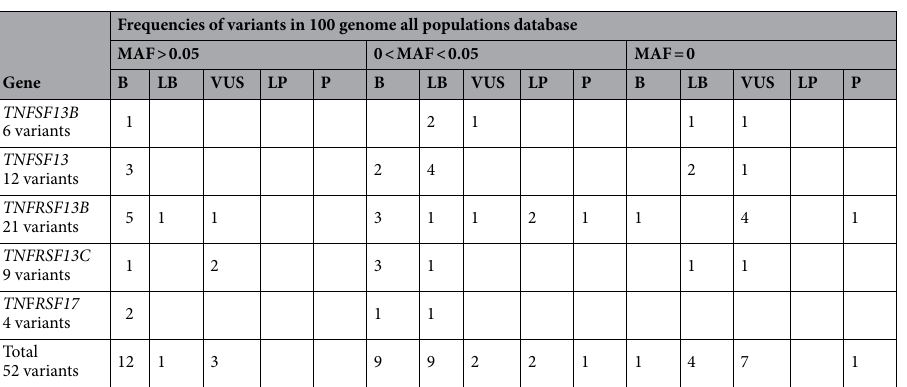
Table 3. Classification of genetic variants according to their MAF and their ACMG pathogenicity criteria. ACMG American College of Medical Genetics and Genomics, MAF minor allele frequency, B benign, LB likely benign, VUS variant of uncertain significance, LP likely pathogenic, P